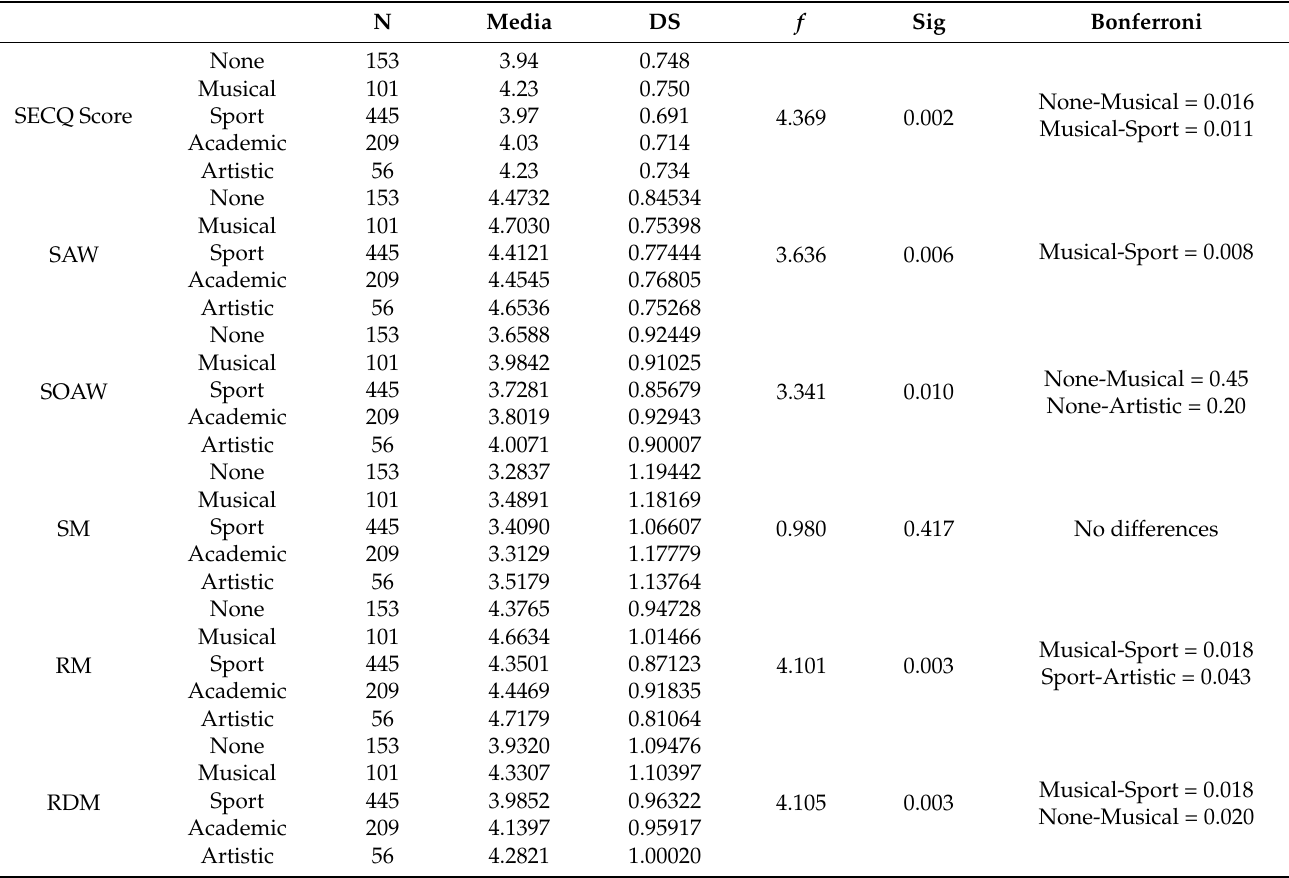
Table 5. Analysis of variance (ANOVA) results for the relation between socio-emotional skills and type of extracurricular activities